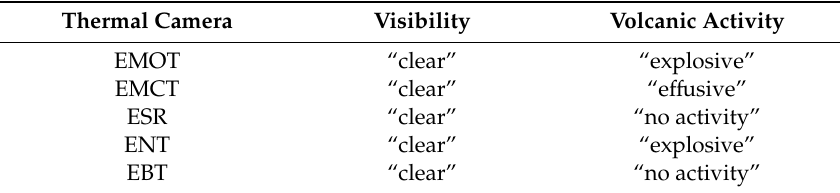
Table 4. Algorithm Outcomes of the DT and BoW-based classifiers for the eruptive activity occurred at SEC on 19 July, 2019.